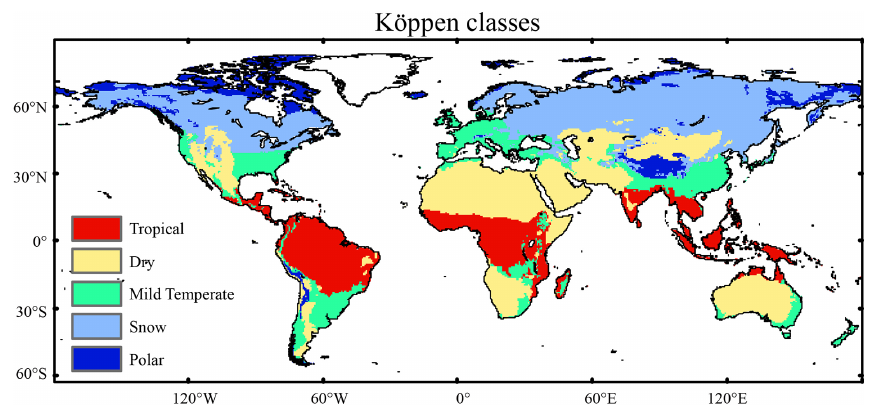
Figure 1. Spatial distribution of five climatic zones using the Köppen climate classification, including tropical, dry, mild temperate, snow, and polar zone (Kottek et al., 2006). Table 1. The main forcing data in four ET products. ET